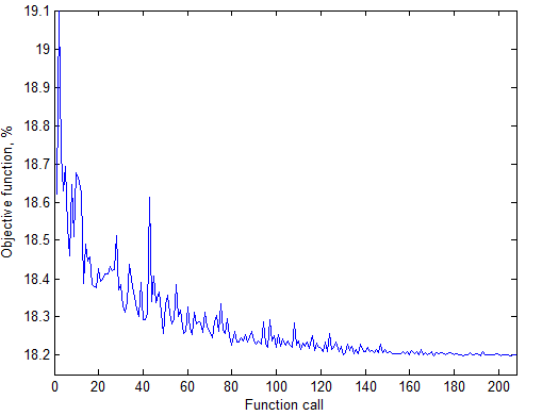
Figure 7. Change of the motor parameters during optimization. ( a ) Symmetrized torque ripple; ( b ) nonsymmetrized torque ripple.